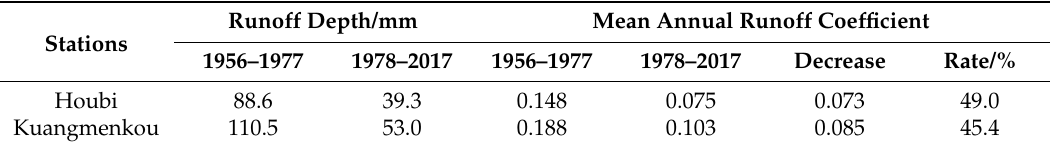
Table 3. The mean annual runoff coefficient of upstream basins of two stations.